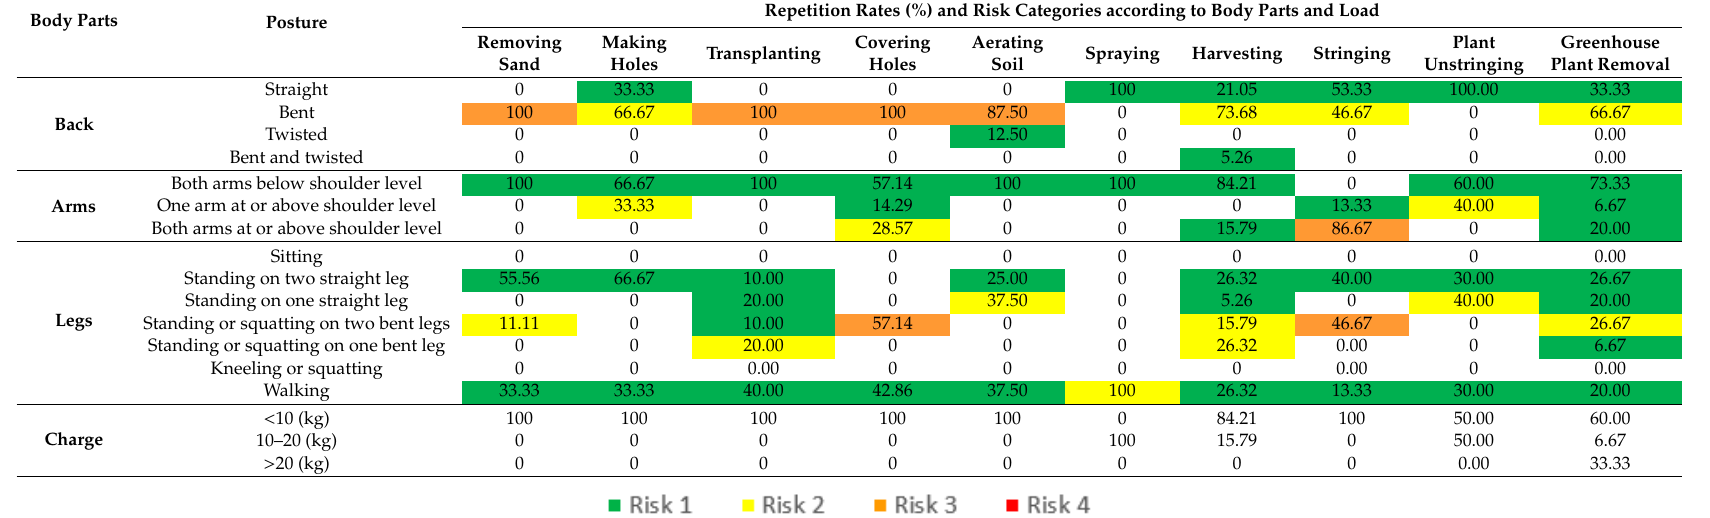
Table 7. Repetition rate and risk category of the position of each body part and of the weight of the handled